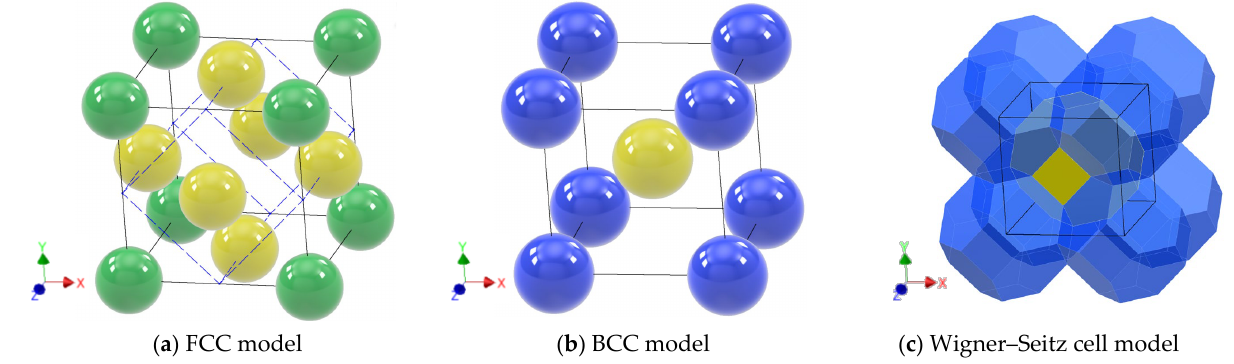
Figure 2. Microstructures of FCC, BCC and Wigner–Seitz cell models.